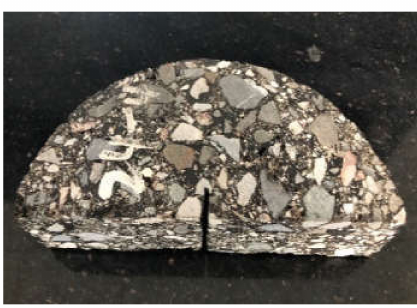
Figure 2. Semicircular bending